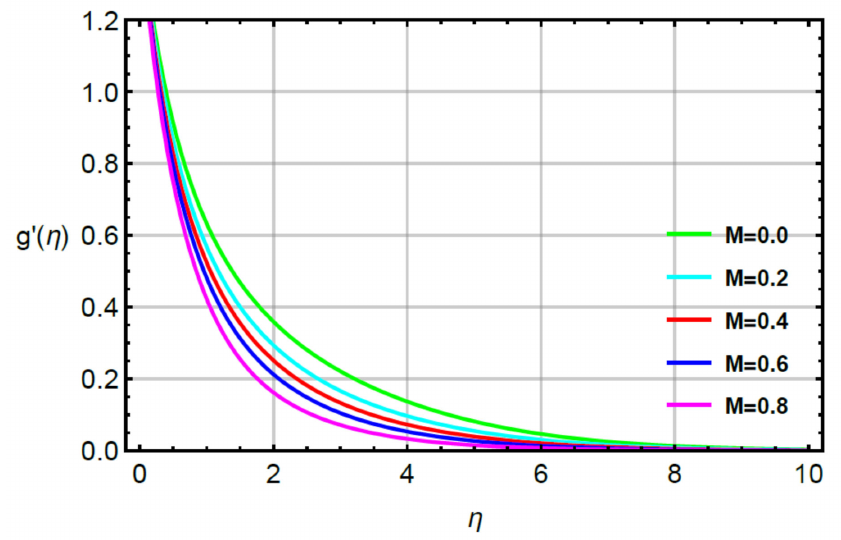
Figure 3. Behavior of g (cid:48) ( η ) for M when R = 0.1, Sc = 0.6, Pr = 1.1, α 1 = 0.2 = α 2 , γ 1 = 0.3 = γ 2 , δ =